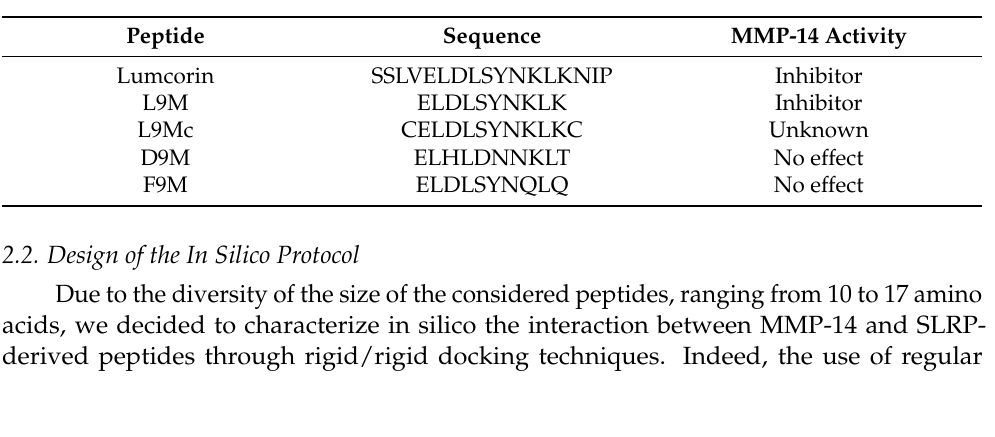
Table 1. Peptide sequences considered in the study.